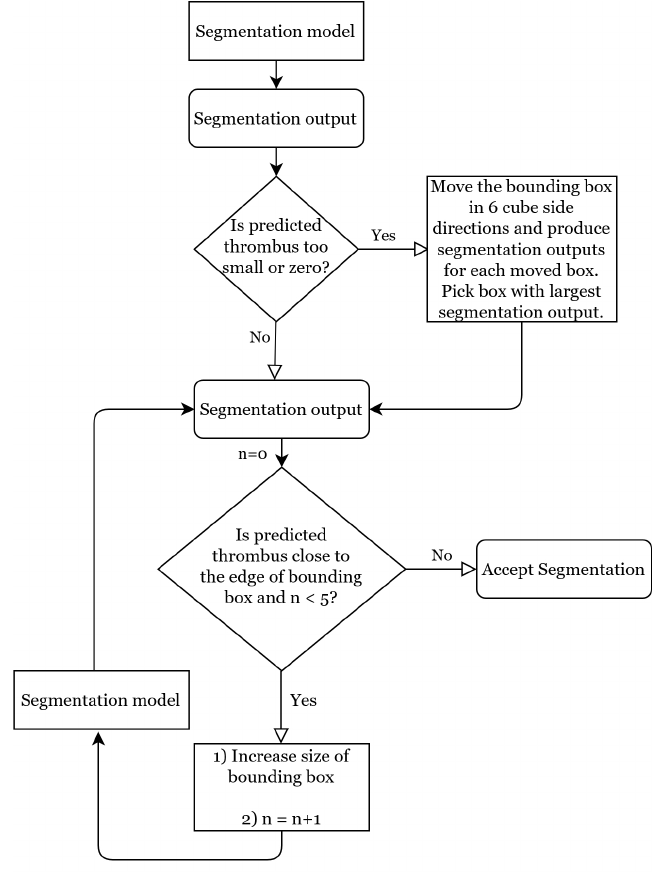
Figure 4. Flow chart of the dynamic bounding box